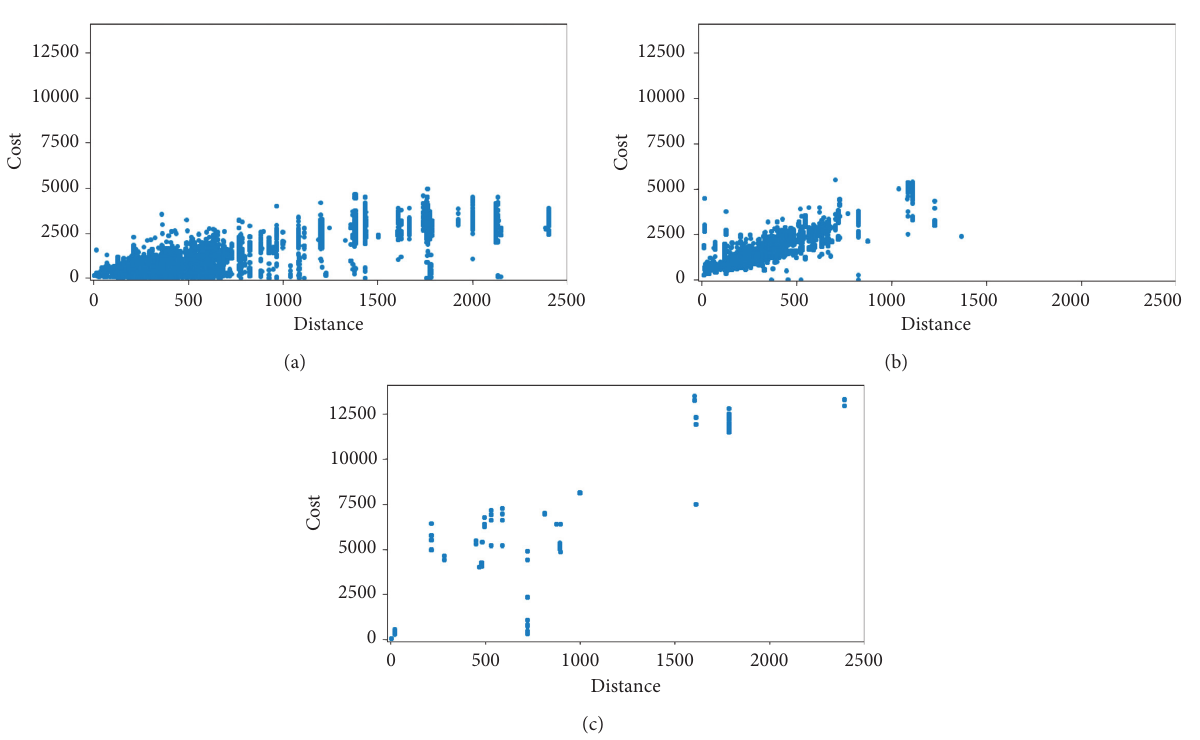
Figure 3: Cost versus shipping distance using actual data for three transportation options: (a) box truck; (b) bulk truck; (c)